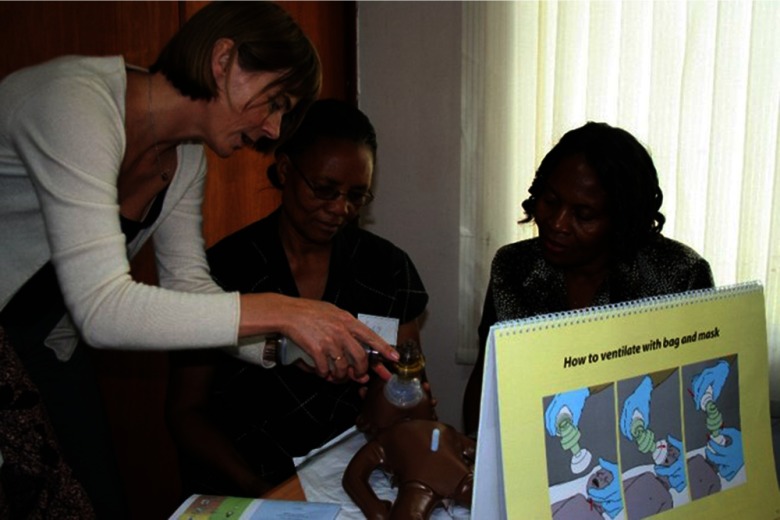
Pilot testing of Helping Babies Breathe 1st Edition in Dar es Salaam, Tanzania. © 2010 Eileen Schoen/American Academy of Pediatrics.